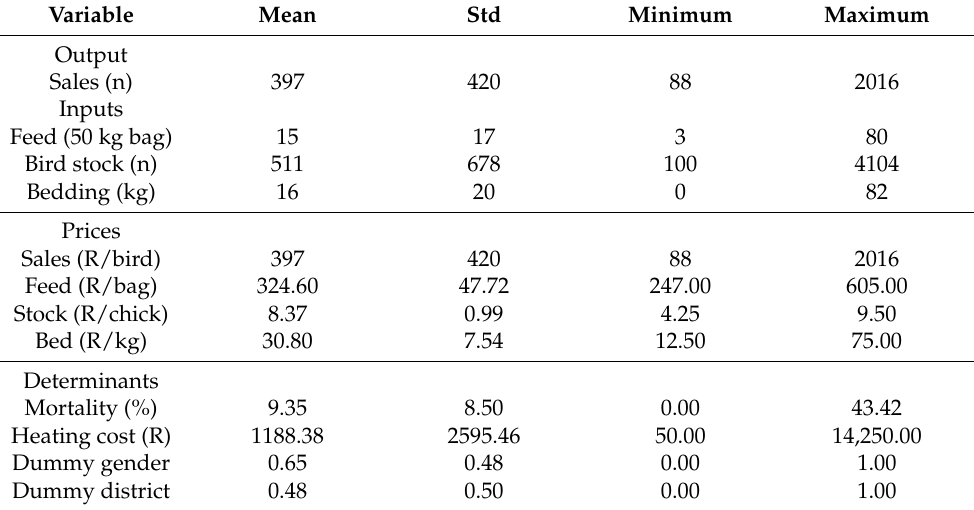
Table 1. Descriptive summary of the output and input